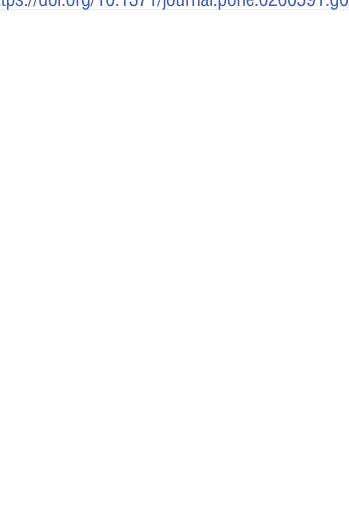
Procedures and statistical analysis